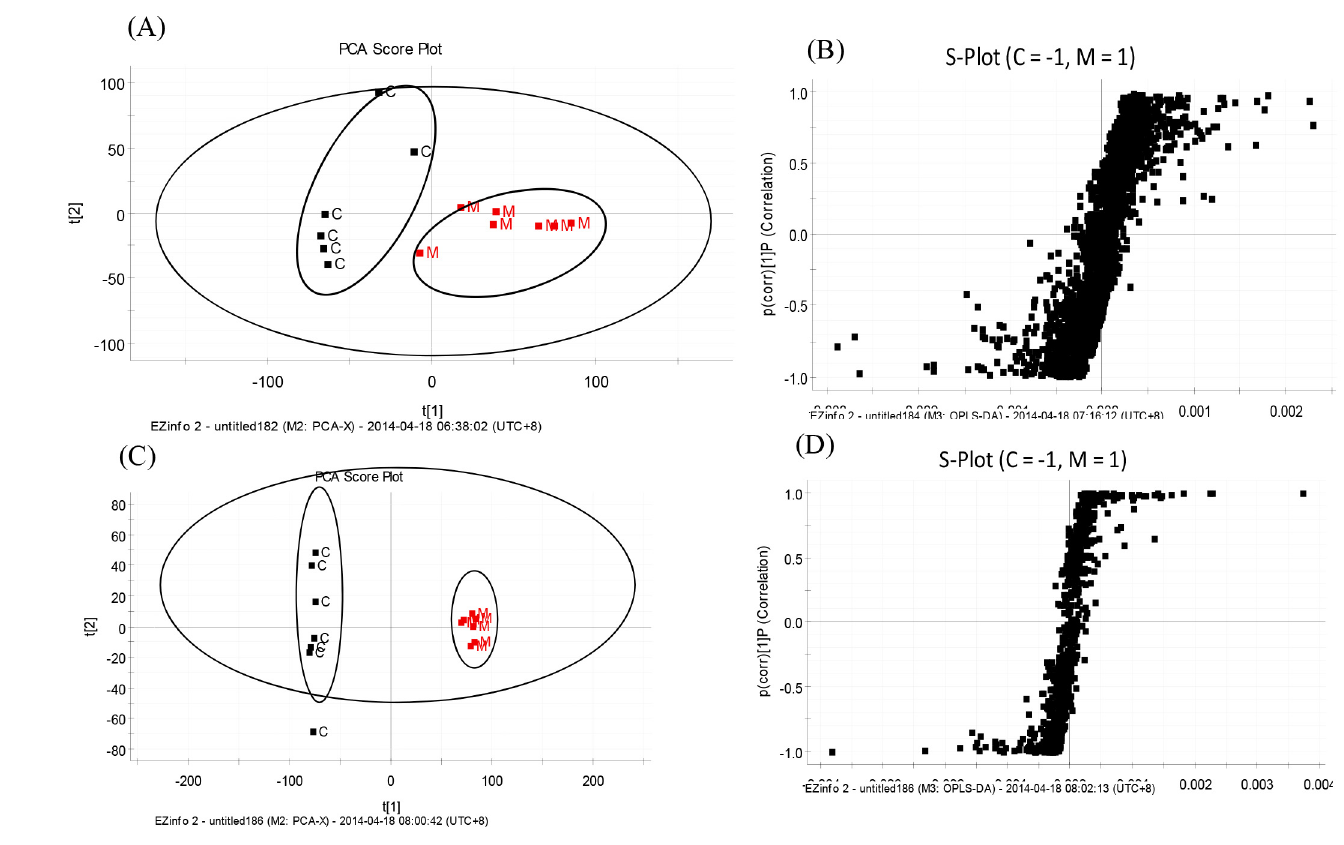
Fig 2. Plasma PCA score plot (A), S-plot of OPLS-DA data (B), hippocampal tissue PCA score plot (C), and S-plot of OPLS-DA data between the sham-operated and model groups in negative mode (D). C, sham-operated group, M, model group.